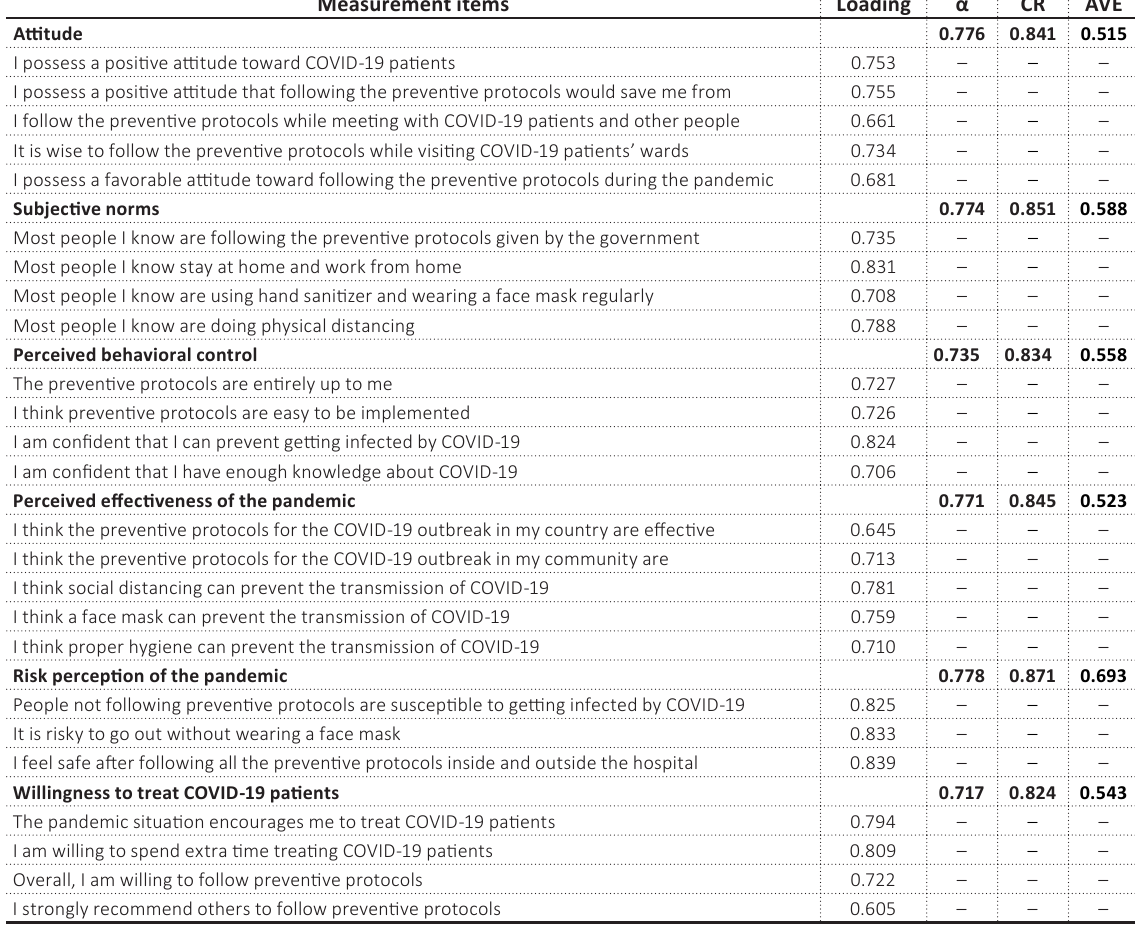
Table 3. Discriminant validity